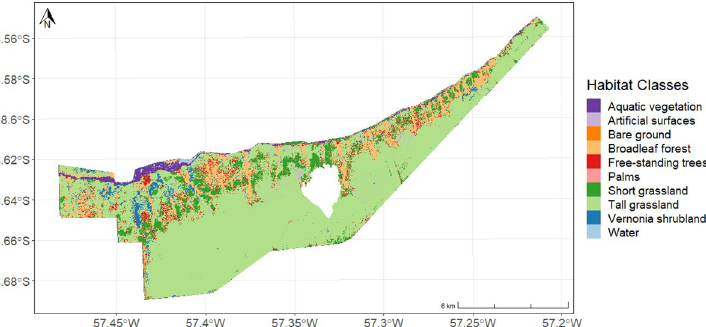
Fig 2. Habitat classification. Map of habitat classes of the study site, Rinco´n del Socorro. The site was classified into ten habitat classes: aquatic vegetation, artificial surfaces, bare ground, broadleaf forest, free-standing trees, palms, short grassland, tall grassland, Vernonia shrubland, and water.